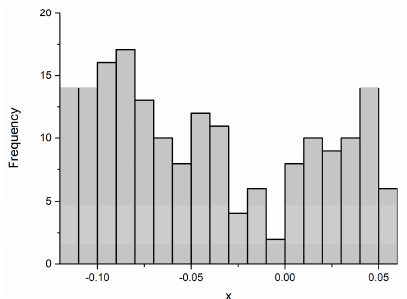
Figure 10. The edge distribution of all filtered points in the x-axis direction.